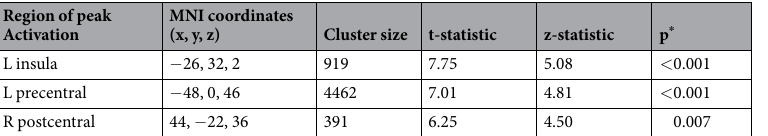
Table 4. Correlation between exercise-related changes ( Exercise – Movie ) in brain activation during correct inhibition trials of the Go/No-go task and task performance in the control condition (correct inhibition rate)